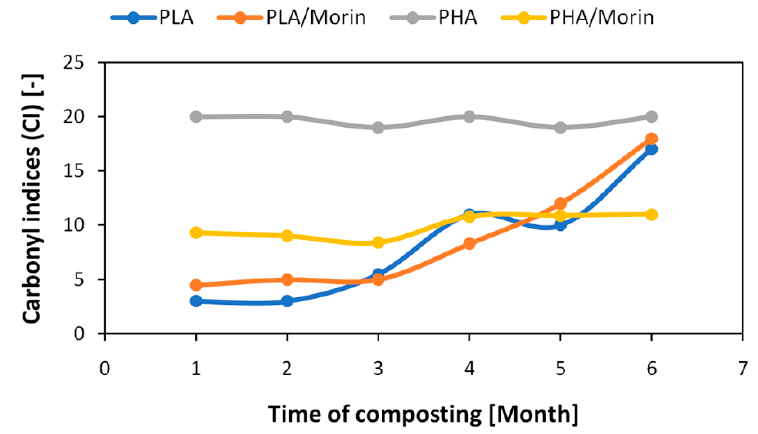
Figure 6. Carbonyl indices (CI) of selected PLA and PHA samples during composting.